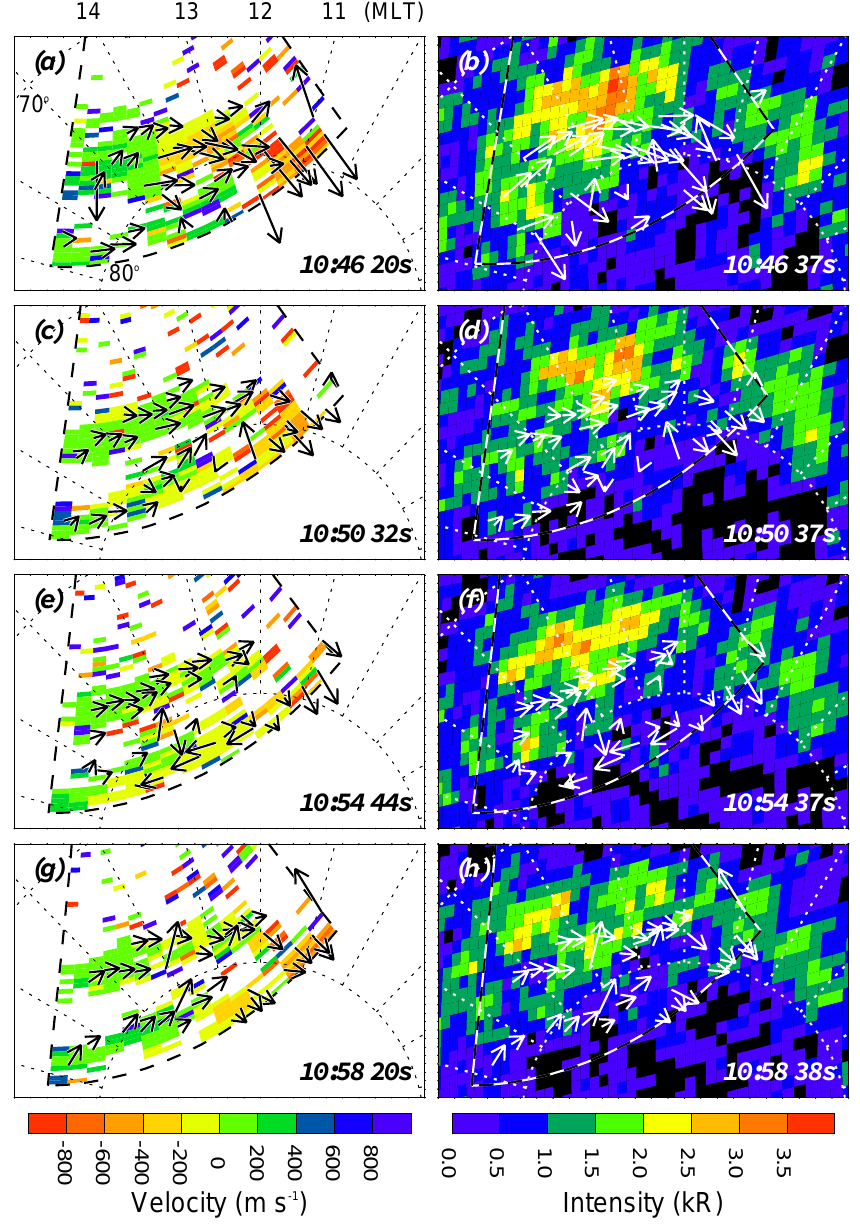
Fig. 4. CUTLASS Hankasalmi line-of- sight velocity scans and Polar VIS im- ages for the interval 1046:20–1058:20 UT. Format as for Fig.